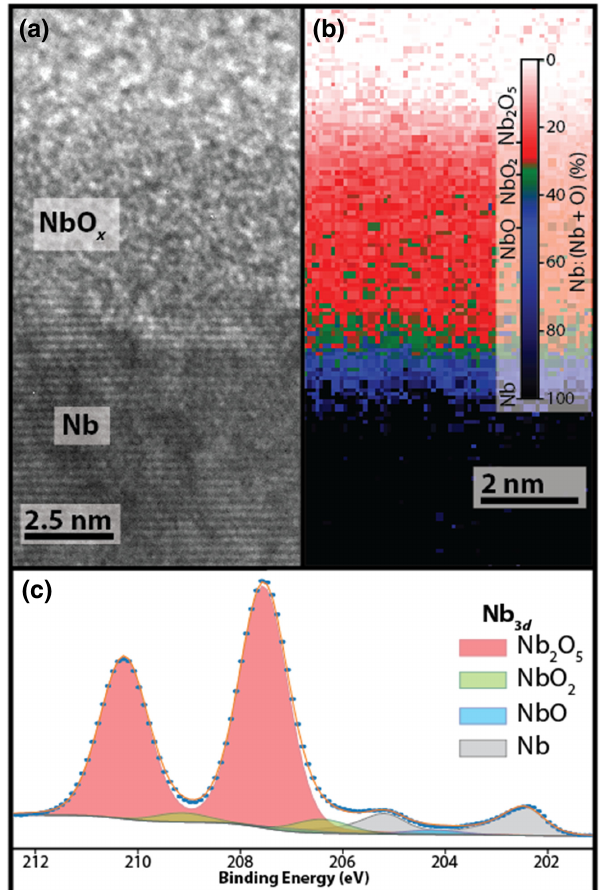
FIG. 3. The niobium metal-air (MA) interface. (a) A high- resolution TEM image showing the MA surface roughness and the approximately 4.8-nm NbO x amorphous oxide. (b) A STEM- EELS map of variations in the Nb:(Nb + O) ratio within the oxide. (c) A Nb 3 d XPS spectrum with peak fits to the different oxide components.